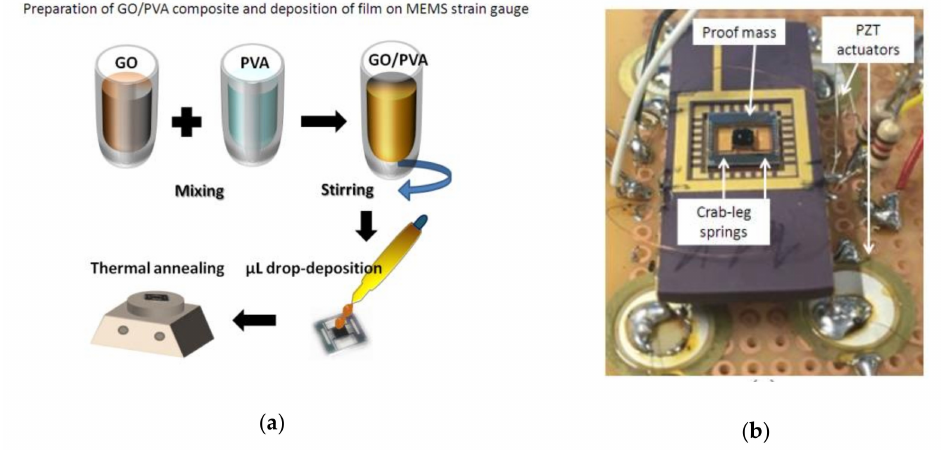
Figure 1. Sensor fabrication: ( a ) graphene-oxide / polyvinyl-alcohol (GO / PVA) composite preparation by solution mixing and deposition on the micromachined sensor and ( b ) the realized microsensor and four PZT elements used to move the